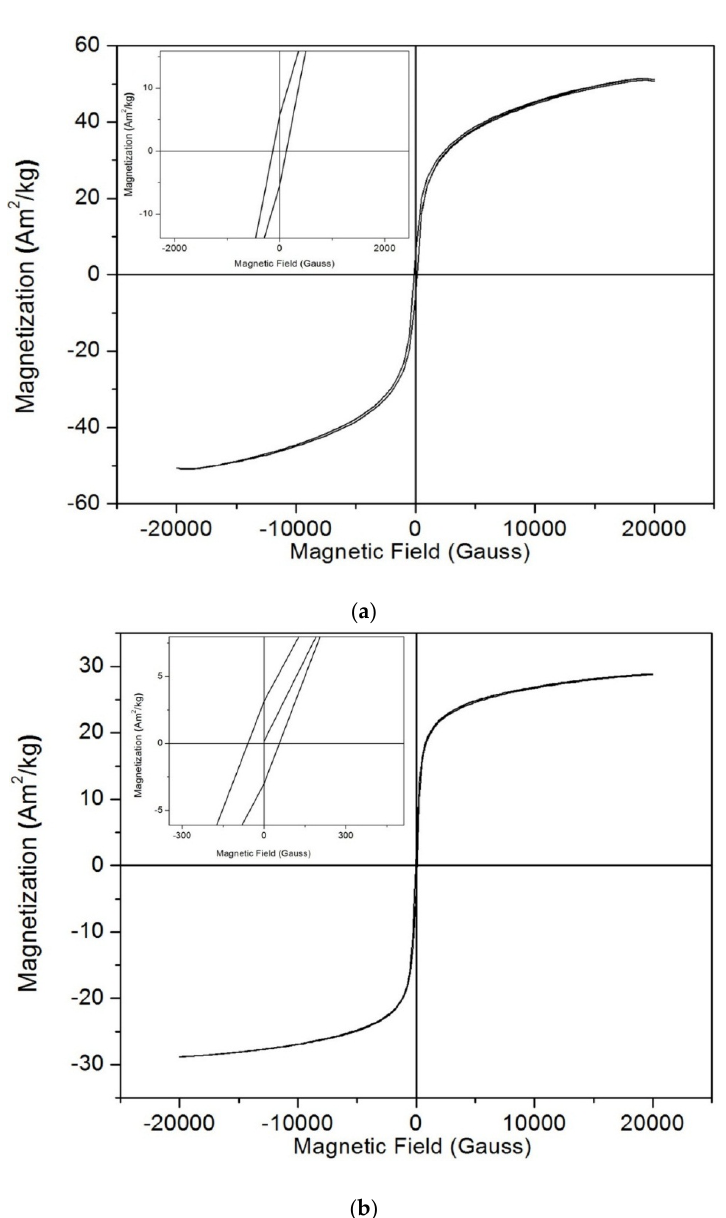
Figure 4. ( a ) Hysteresis loop of CuFe 2 O 4 nanopowder at room temperature; ( b ) Hysteresis loop of ZnFe 2 O 4 nanopowder at room